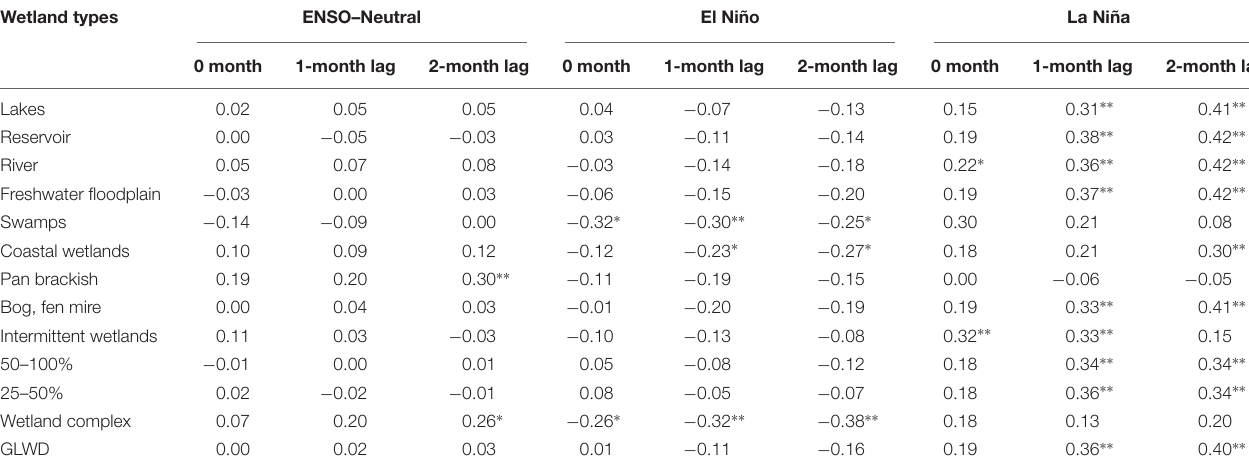
TABLE 2 | Correlation of Global lakes and wetland classes with monthly Niño3.4 SSTA along with El Niño and La Niña months from 1995 to 2015. Wetland types